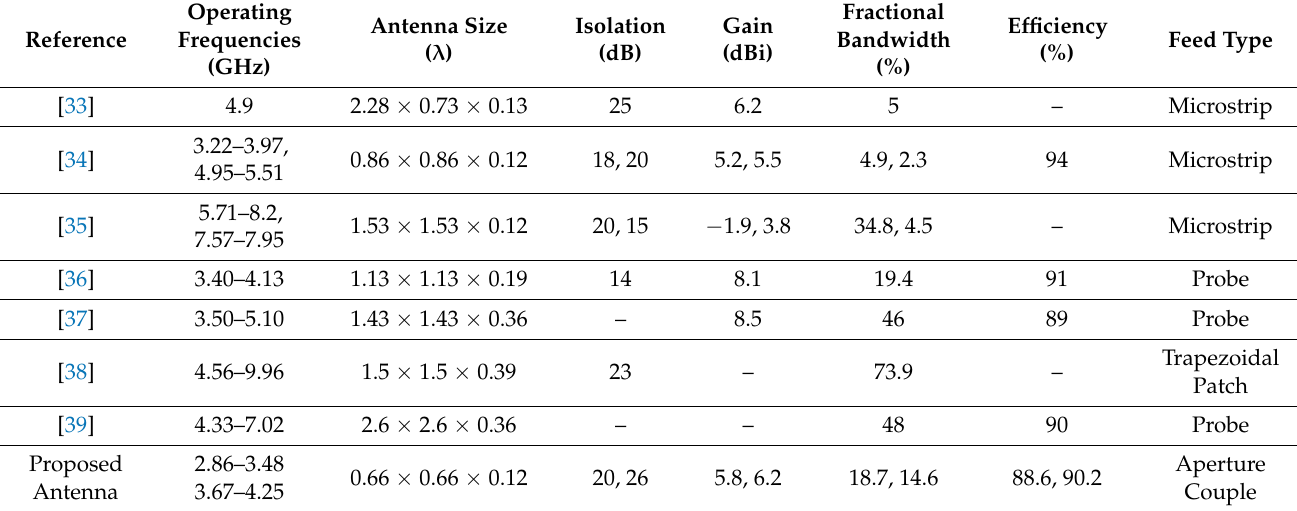
Figure 13. Mean effective gain. Table 2. Comparison of the proposed antenna with the literature.